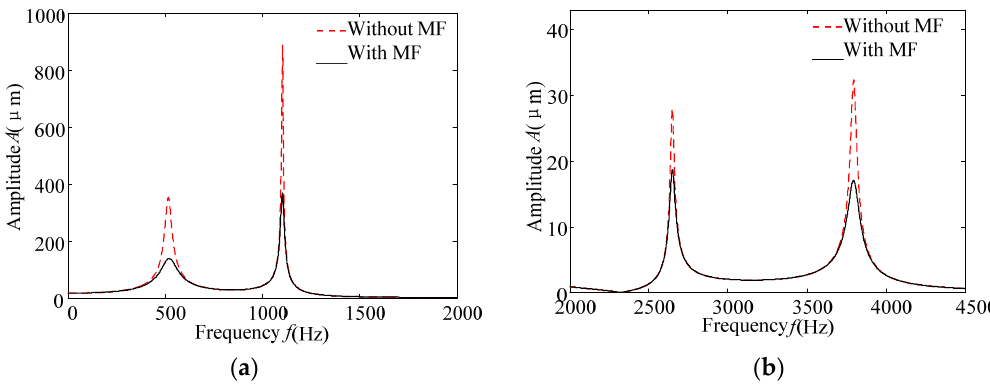
Figure 5. Predicted harmonic responses in the x- direction (with and without magnetic fluids).